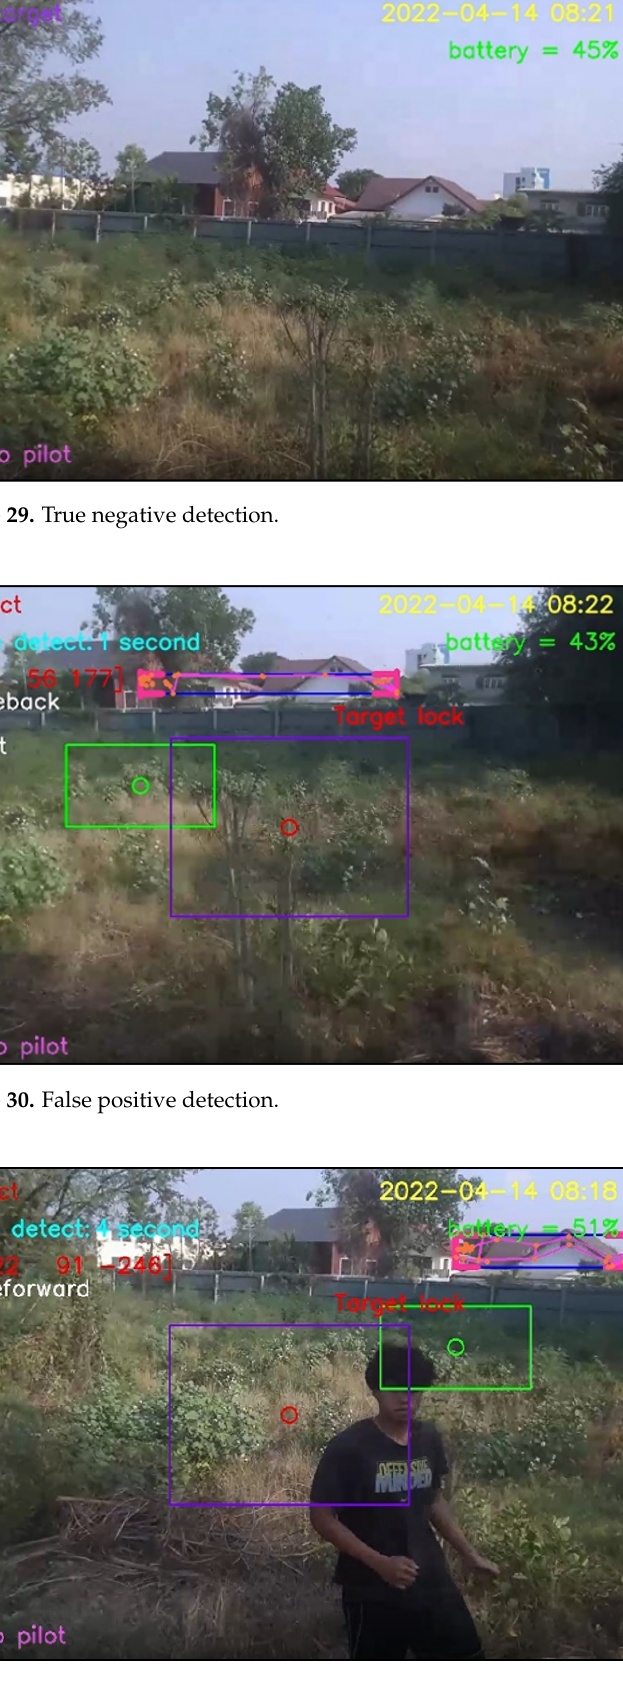
Figure 31. False negative